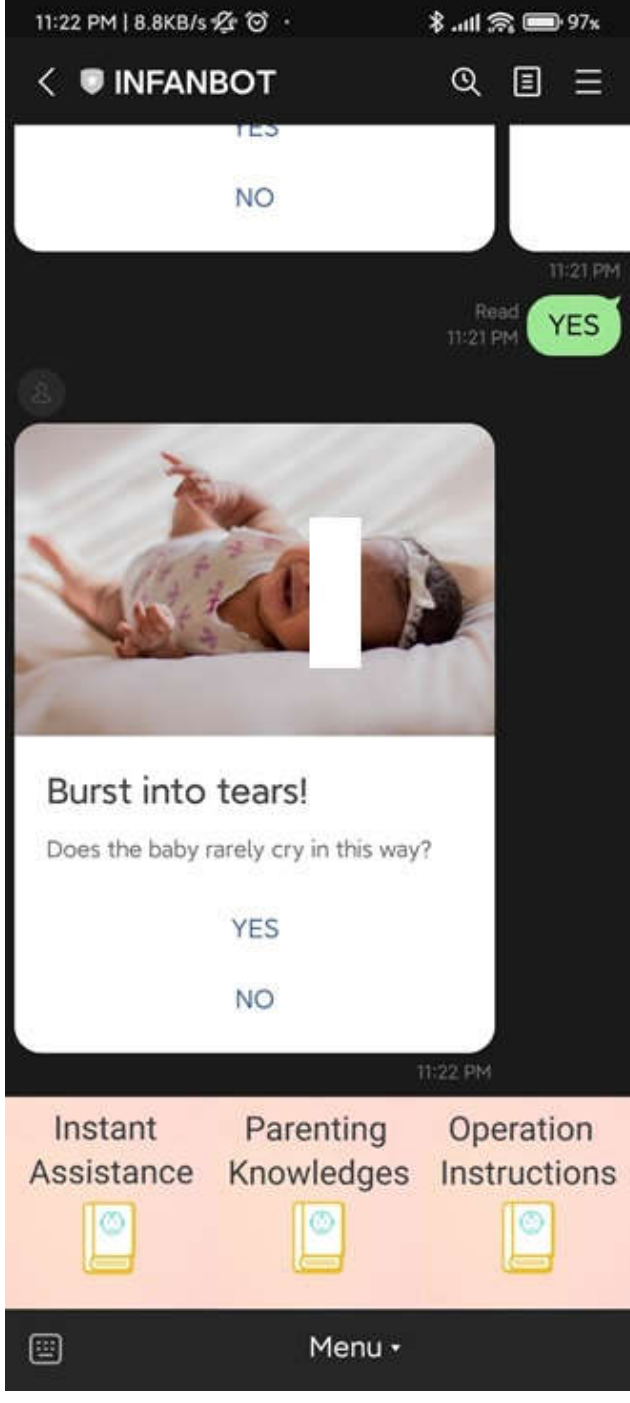
Figure 5. The first yes or no question.